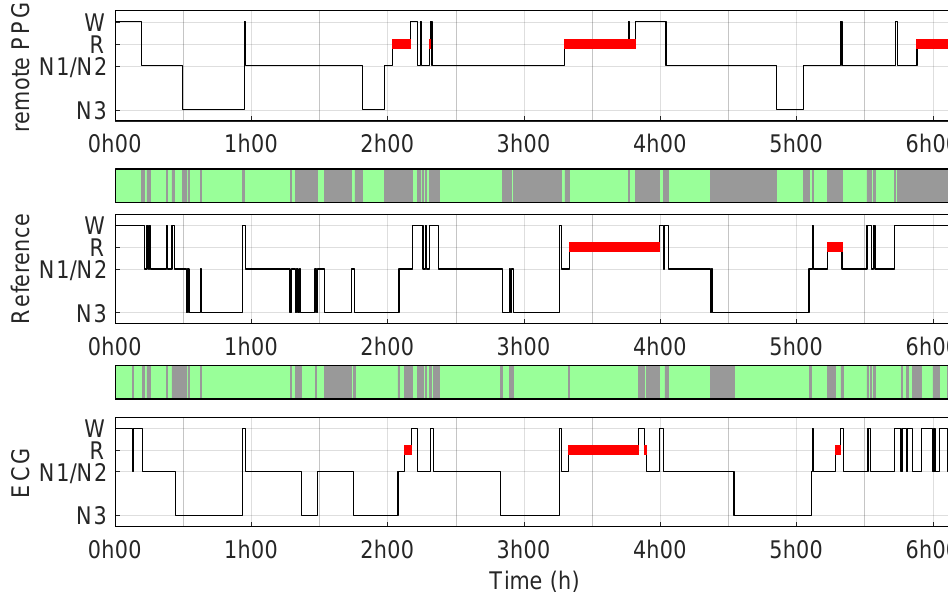
Figure 5. Hypnogram with a higher N3 classification sensitivity with ECG than with Remote PPG. Hypnograms for one example recording of a participant where ECG achieved a higher N3 classifica- tion sensitivity than with remote PPG; ( top ) Hypnogram predictions using remote PPG, accuracy 58%, κ remotePPG = 0.39 vs. reference PSG; ( middle ) reference hypnogram based on PSG manual scoring; ( bottom ) hypnogram predictions using ECG, accuracy 80% κ ECG = 0.71 vs. reference PSG. Table 2 indicates the pulse detection performance of the remote PPG setup in compar- ison with ECG. The coverage of IPI time series of the remote PPG setup was on average 83.1%, a minimum of 63.3% and a maximum of 91.5%. The pulse detection algorithm achieved a relatively high mean sensitivity of 83.1% ± 6.9, and PPV of 96.6% ± 3.9 com- pared to ECG. Even in participants where the coverage and sensitivity is low, the localiza- tion is very accurate, with a minimum and average of 86.2% and 94%, respectively, of the correctly detected pulses found within 100 ms of the corresponding QRS complex. Table 2. Pulse detection performance of the remote PPG setup, in comparison with ECG. Parameter (Unit) Mean SD Min.